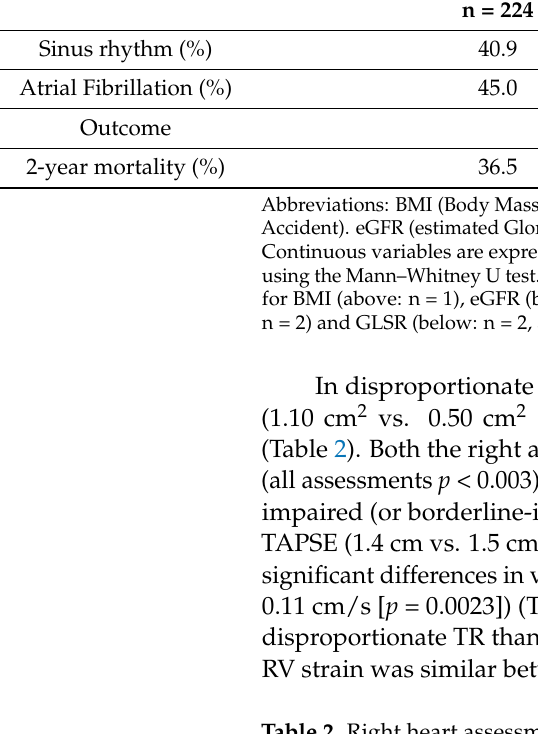
Table 2. Right heart assessment of patients delineated by threshold disproportionate TR. Tricuspid